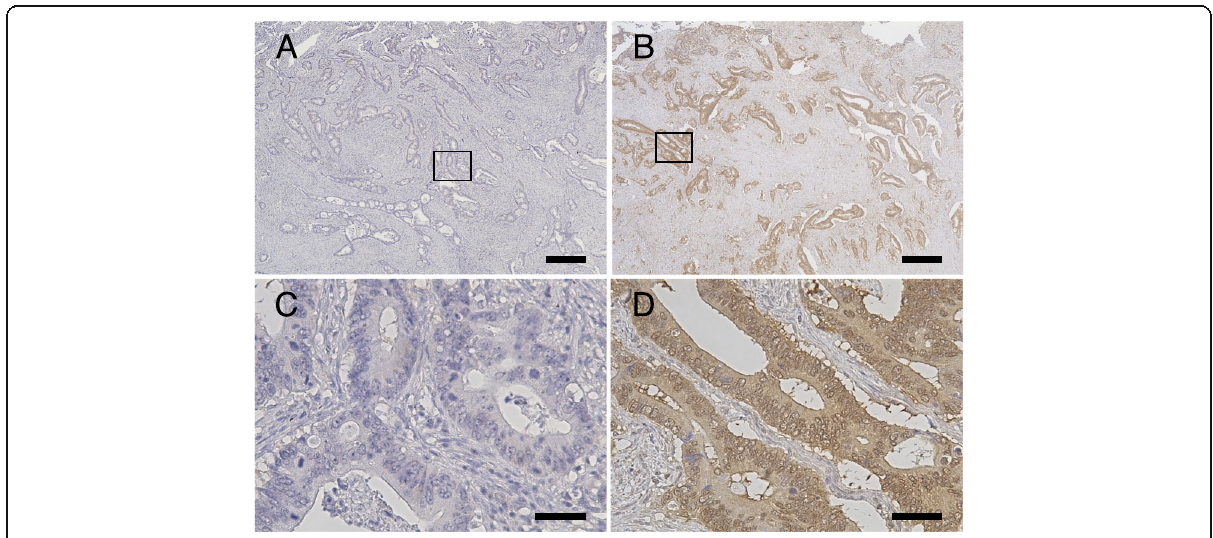
Fig. 3 Immunohistochemical staining for AMIGO2 expression by the monoclonal antibody rTNK1A0012 in CRC tissues. AMIGO2 negative expression ( A and C ) and AMIGO2 high expression ( B and D ) are shown. The lower row are shown at higher magnification. Scale bars = 400 μ m ( A and B ) and 100 μ m ( C and D )